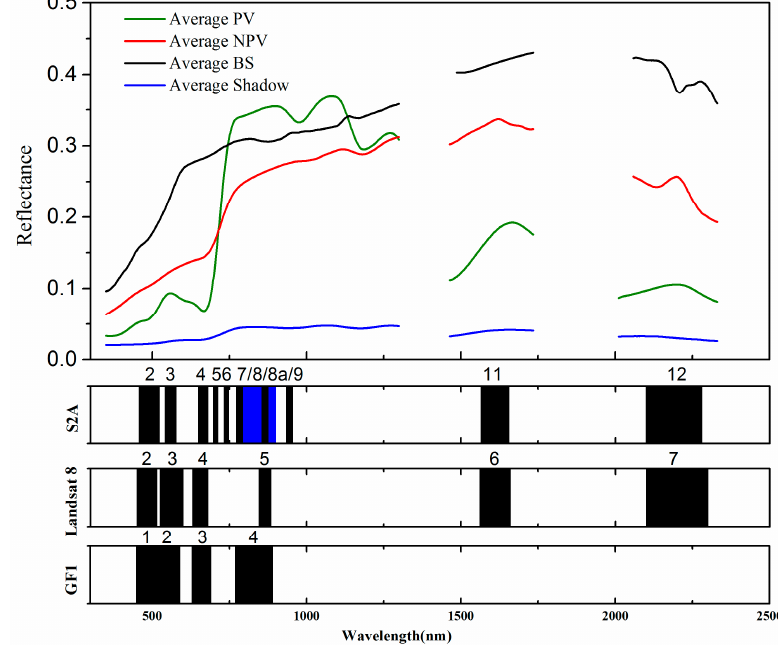
Figure 6. Average reflectance of selected PV, NPV, BS, and shadow endmembers, and band position of three main sensors.